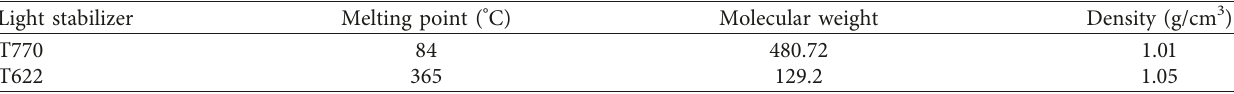
Figure 1: Molecular structure of T770 and T662 light stabilizers. Table 1: Technical properties of light stabilizer.